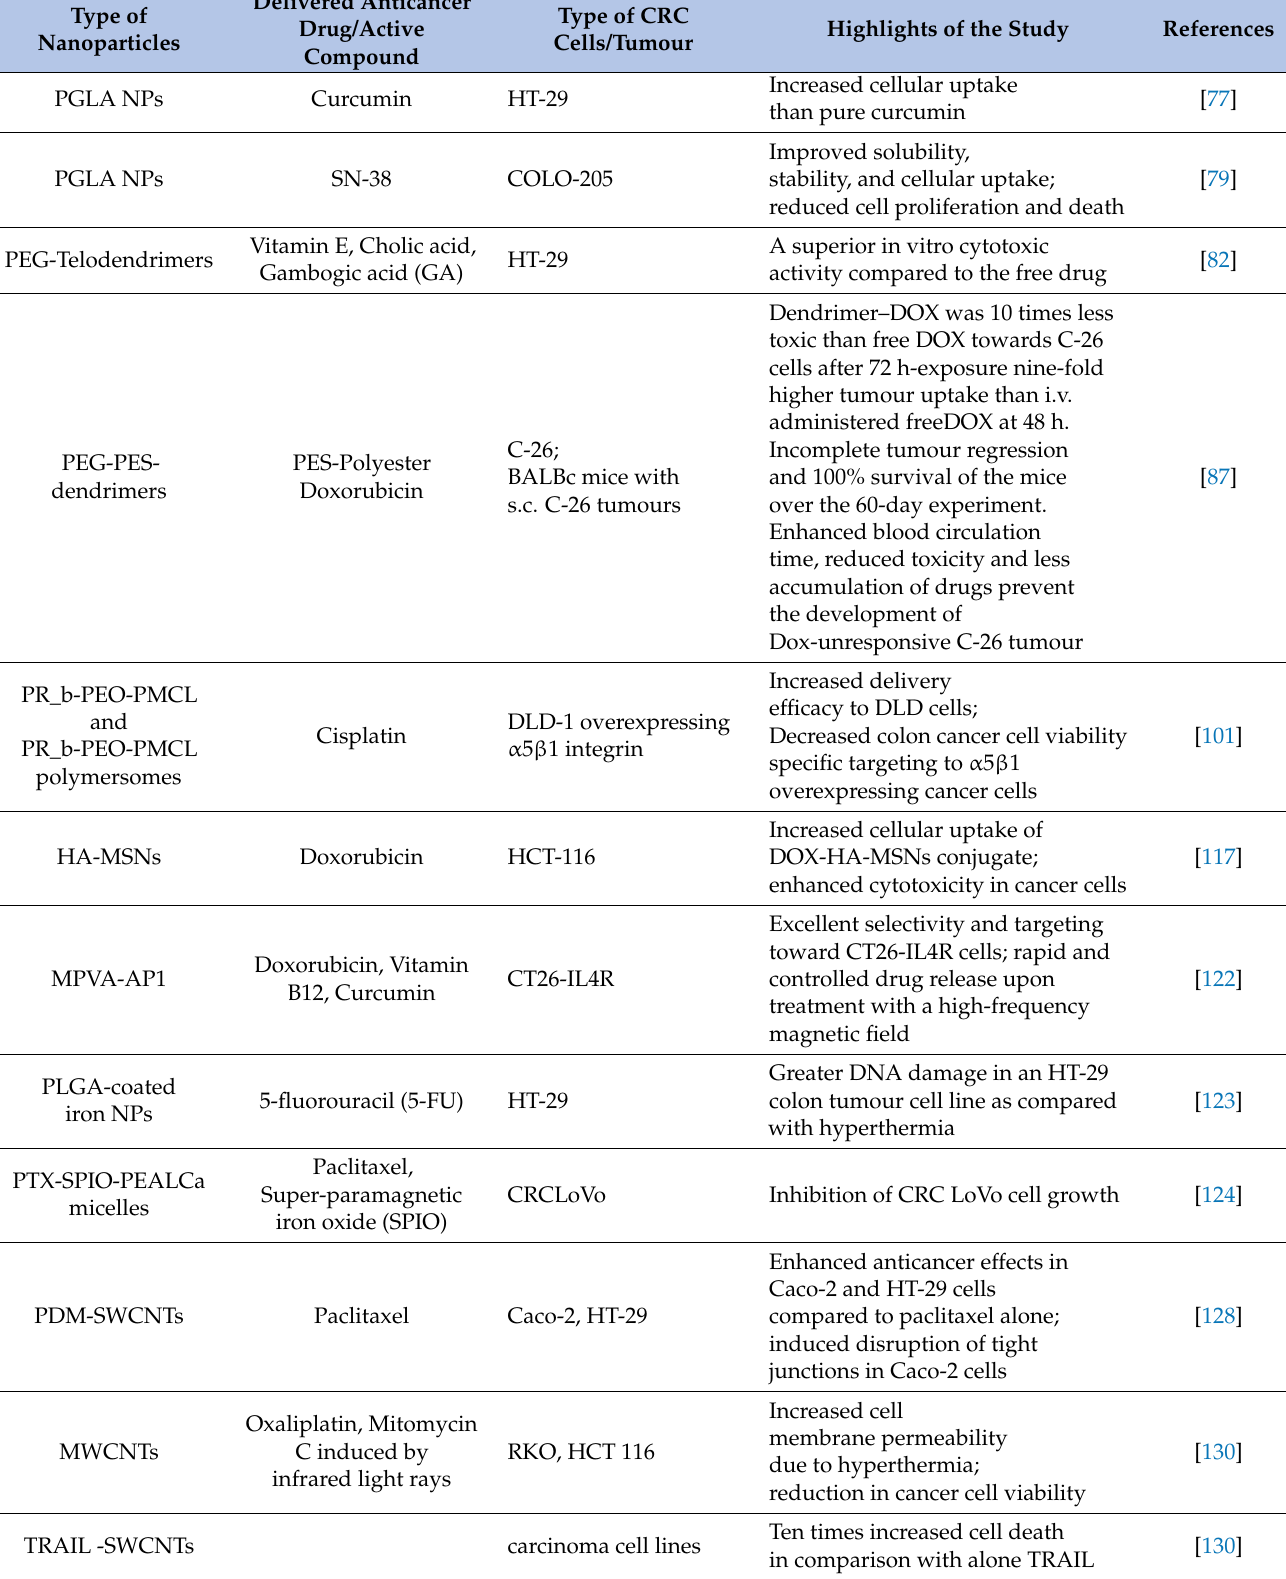
Table 3. Nanoparticle-based nanoformulations were used in in vitro and in vivo colorectal cancer